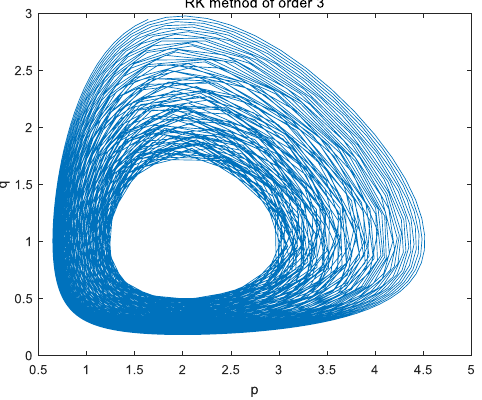
Figure 3. Trajectory of the non-canonical variable.